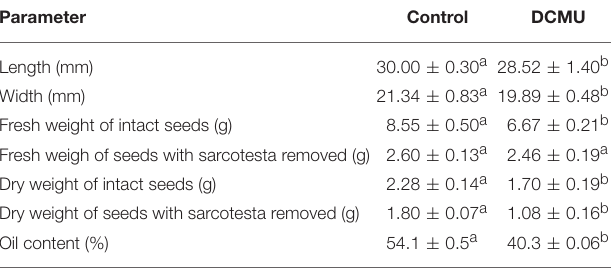
TABLE 3 | Changes in Torreya grandis cv. “Merrillii” seed characters caused by treatment with 3-(3,4-dichlorophenyl)-1,1-dimethylurea (DCMU) in 2015.